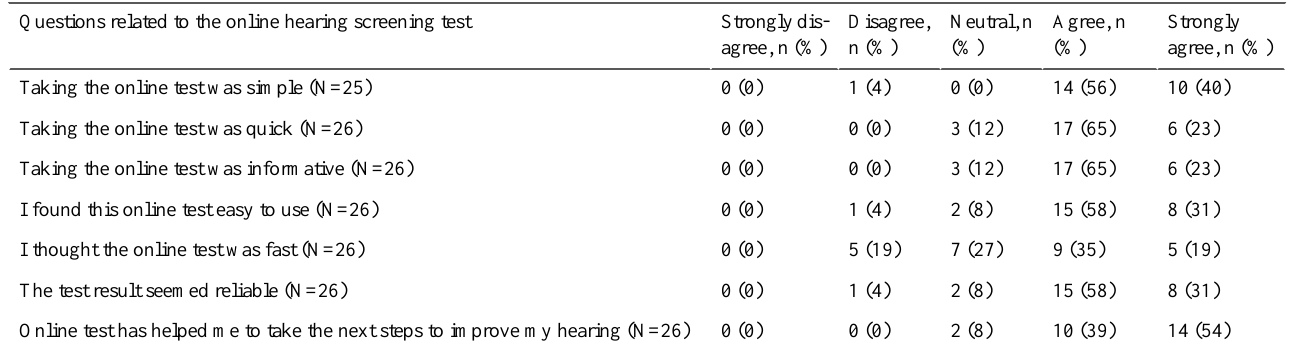
Table 1. Patient evaluation of the online hearing screening test.